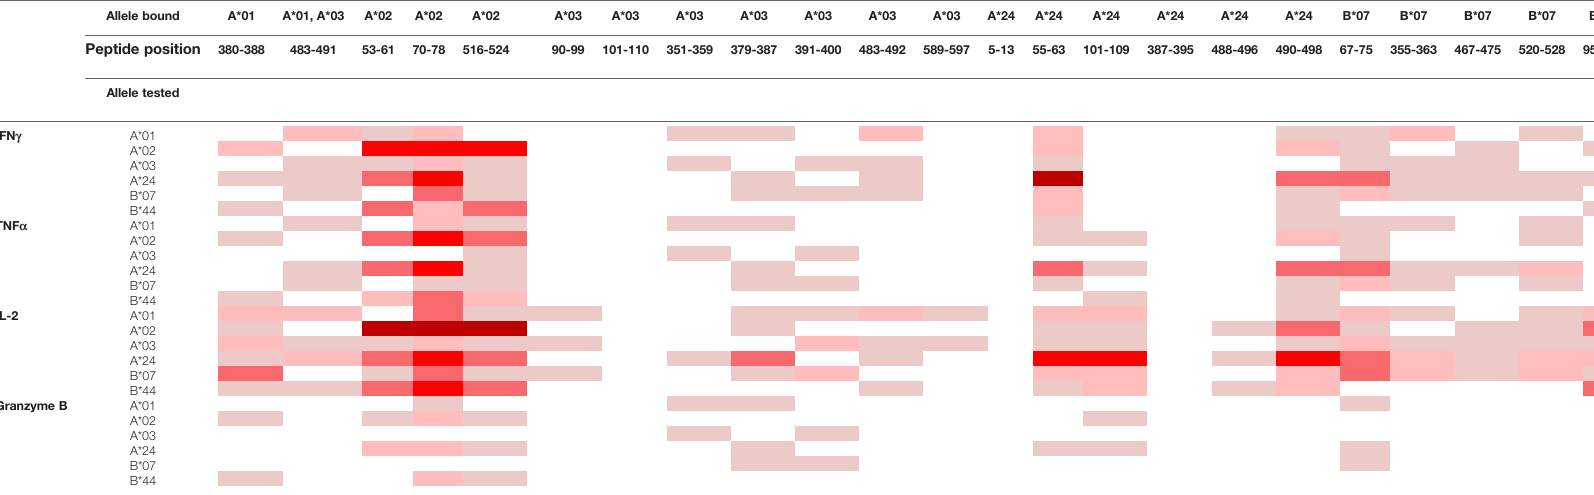
TABLE 3 | Summary of immune response to the class I peptides for PF08_0081 by different donor HLA supertypes.